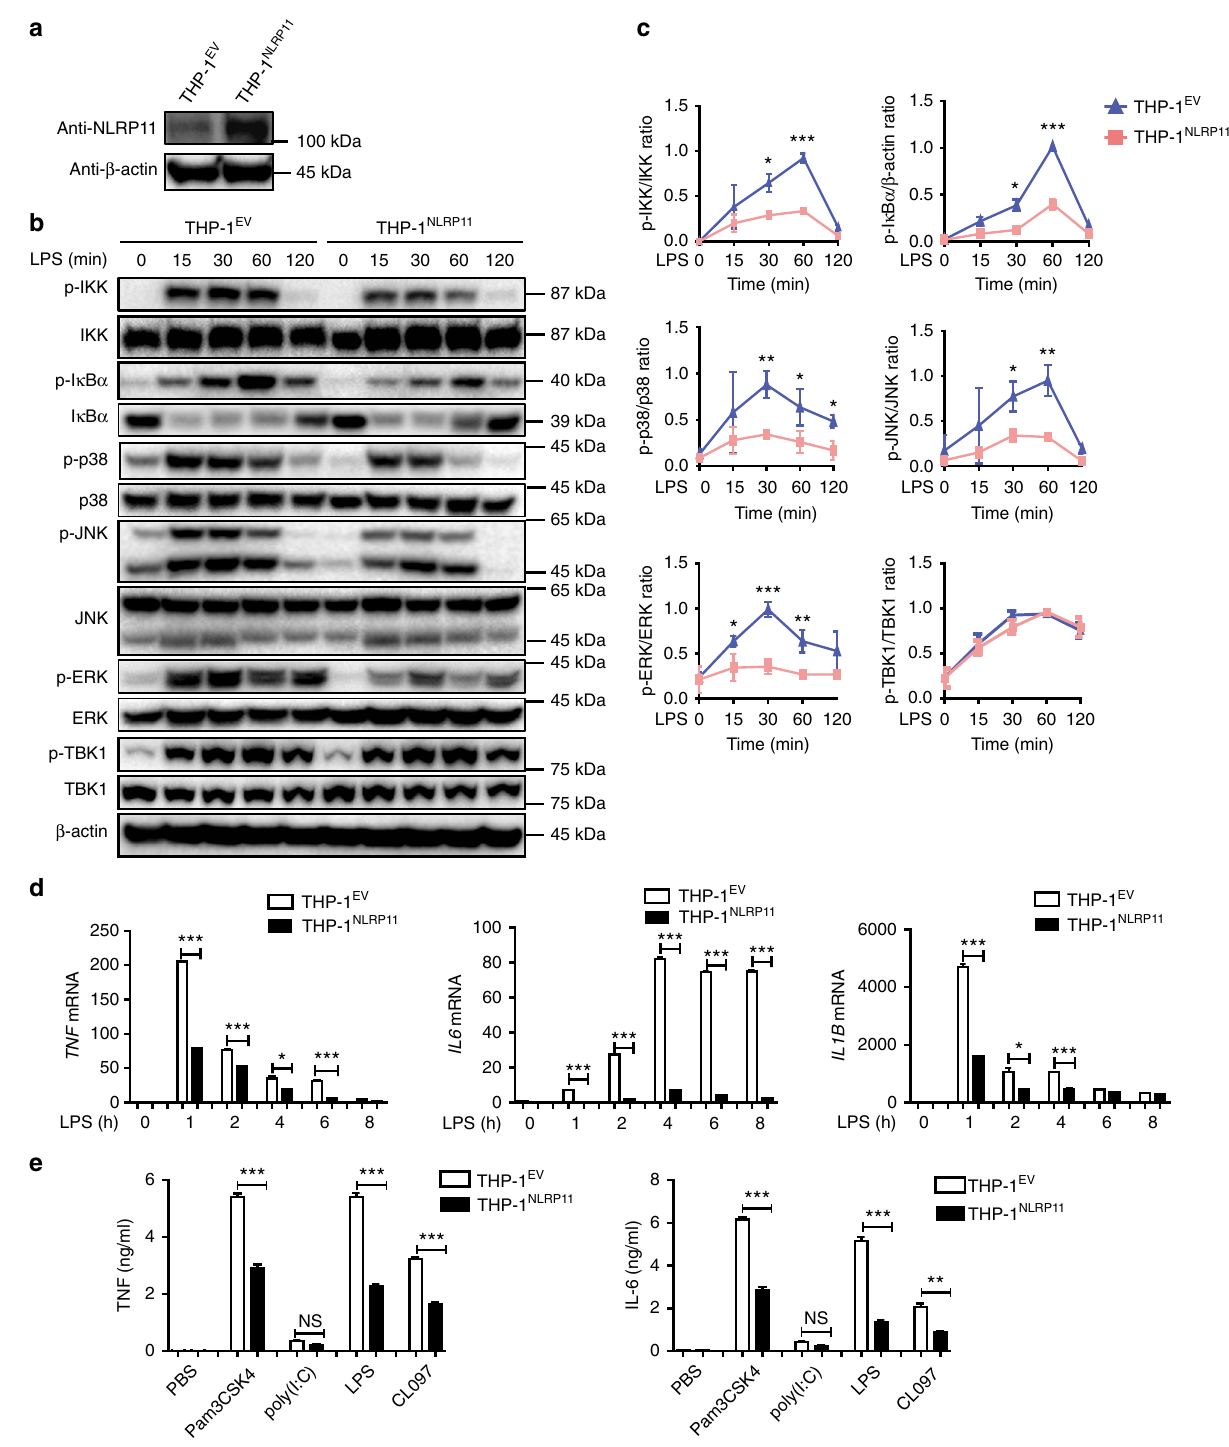
Fig. 2 NLRP11 inhibits LPS-induced NF- κ B activation. a Immunoblot analysis of NLRP11 in WT THP-1 cells stably expressing the empty vector (THP-1 EV ) or Flag-tagged NLRP11 (THP-1 NLRP11 ). b THP-1 EV and THP-1 NLRP11 cells were stimulated with LPS (100 ng/ml) for the indicated periods, then the cell lysates were analyzed by immunoblot analysis of total and phosphorylated IKK, I κ B α , TBK1, and MAPKs (p38, JNK, and ERK) (representative image). c Quantitative comparison of signalling activation between THP-1 EV and THP-1 NLRP11 cells by density scanning of the blots in three independent experiments. d THP-1 EV and THP-1 NLRP11 cells were stimulated with LPS (100 ng/ml) for the indicated periods, then analyzed by real-time PCR for TNF , IL6 , and IL1B transcription; the results were normalized to the expression of ACTB (encoding β -actin) and are presented relative to those of untreated cells. e THP-1 EV and THP-1 NLRP11 cells were stimulated with LPS (100 ng/ml), poly(I:C) (10 μ g/ml), Pam3CSK4 (100 ng/ml), or CL097 (1 μ g/ml) for 24 h, then the supernatants were analyzed by enzyme-linked immunosorbent assays (ELISAs). Data a , b are representatives of three independent experiments with similar results. Data c are combined from three individual experiments and presented as means ± SEM. Data d , e are expressed as mean ± SEM of combined from three independent experiments with triplicate. * P < 0.05, ** P < 0.01, and *** P < 0.001 using Student ’ s t